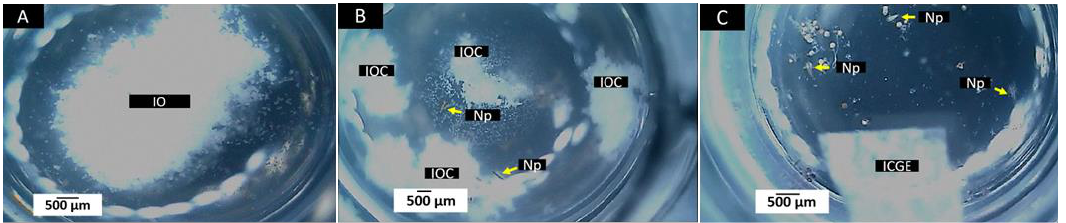
Figure 5. Samples of the materials were incubated for 24 h in a seawater solution with larvae of A. salina . ( A ) Sample F1. IO = Material F1. ( B ) Material F2. 9IOC = Material F2 NP = Nauplius. ( C ) Material F3. ICGE= Material F3. NP= Nauplius. Images at 3×. Images were obtained with a stereoscopic microscope.